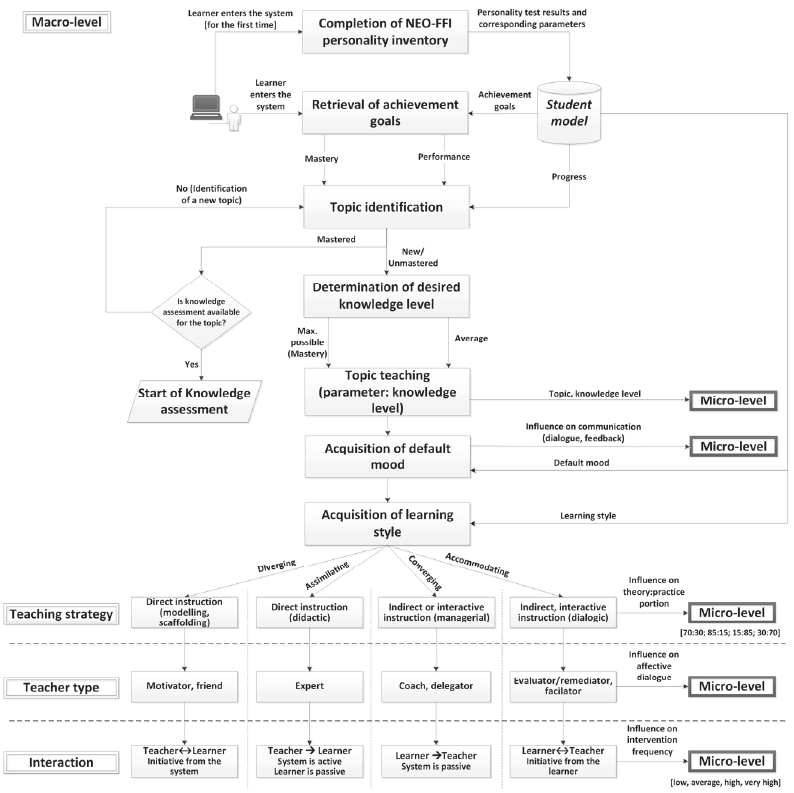
Fig. 1. Adaptation at the macro